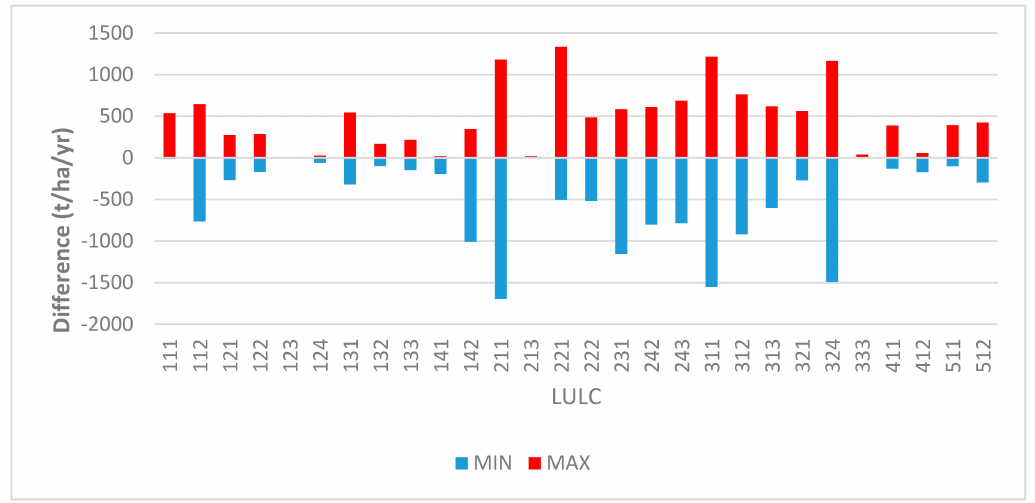
Figure 11. Minimum and maximum values of di ff erences in PESERA and USLE predictions for 2018 by CORINE land cover